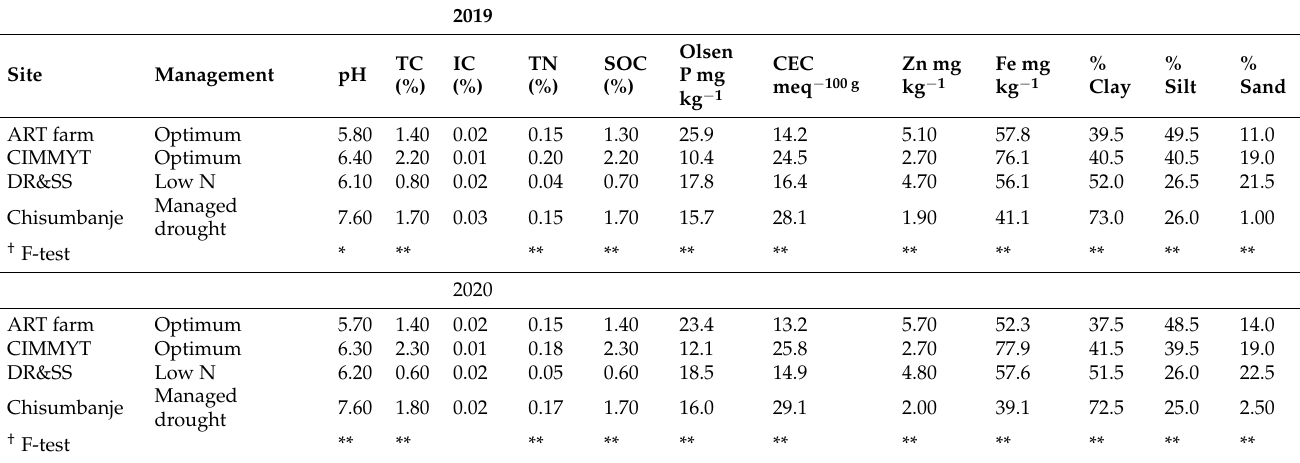
Table 1. Means for extractable soil physicochemical properties of different experimental